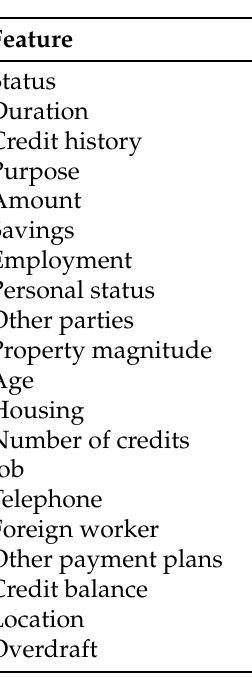
Table 2. Summary table of features in German Credit